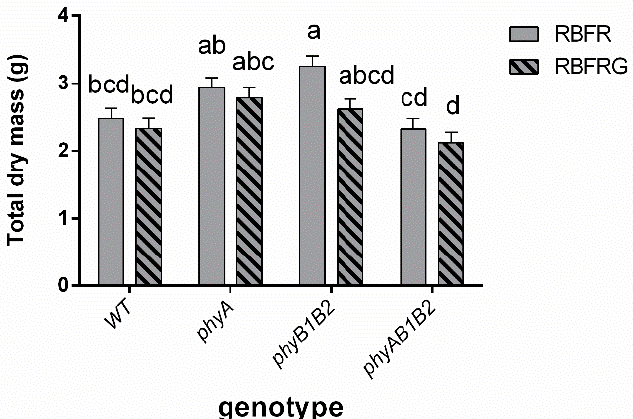
Figure A2. Effects of partial (20%) substitution of red/blue (RB; 3:1) with green (G) light while keeping the PSS constant on the total dry mass (exclude root) of tomato plants 21 days after treatment. Four genotypes were studied: WT (Moneymaker; wild-type), phyA (phytochrome A-deficient), phyB1B2 (phytochrome B1- and B2-deficient), and phyAB1B2 (phytochrome A-, B1-, and B2-deficient). Light treatment and genotype did not significantly interact ( p = 0.501), but the effects of genotype were significant ( p = 0.003). Lower case letters indicate significant differences among the combinations of light treatment and genotype ( p = 0.05). Data presented are averages, with the SE based on 4 blocks ( n = 4), each containing 3 replicate plants (Exp2).